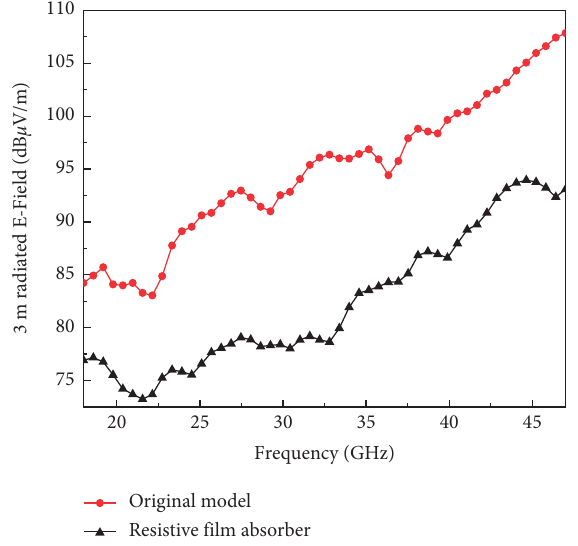
Figure 25: Radiated E-Field of package at 3 m.